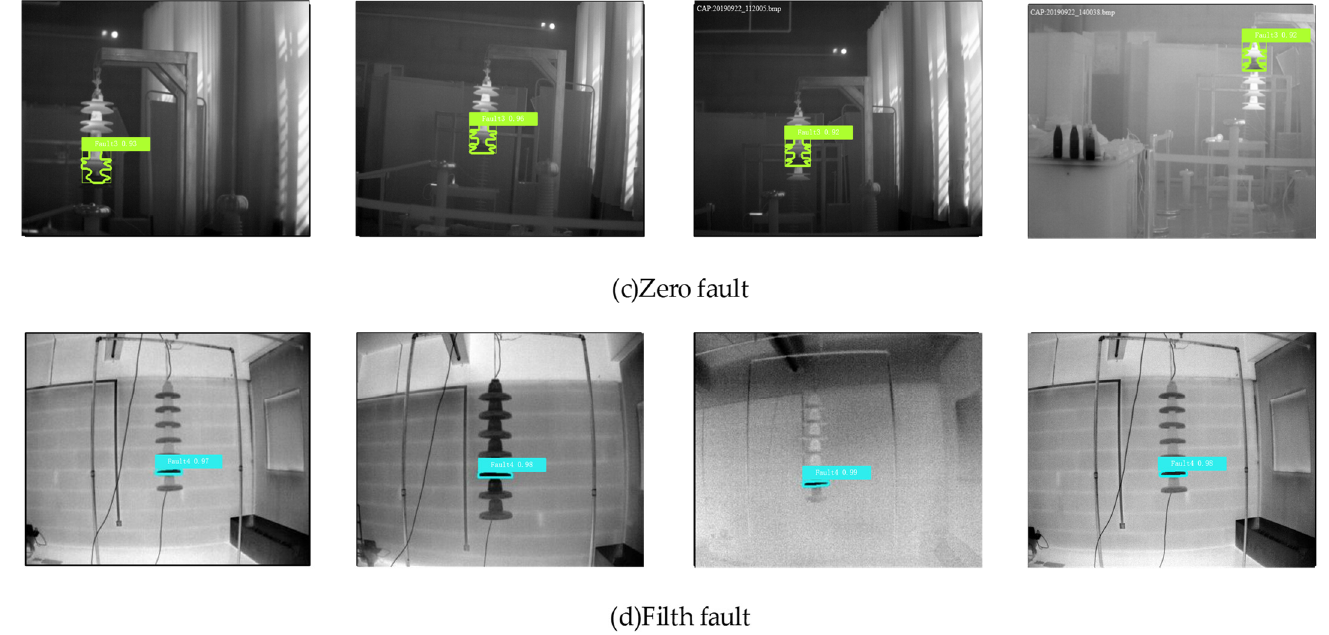
Figure 11. The effect of fault identification at different positions.